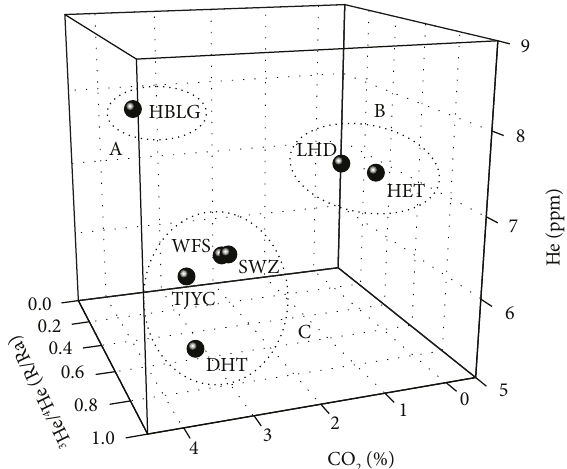
concentrations 2 concentrations from the wells. 2